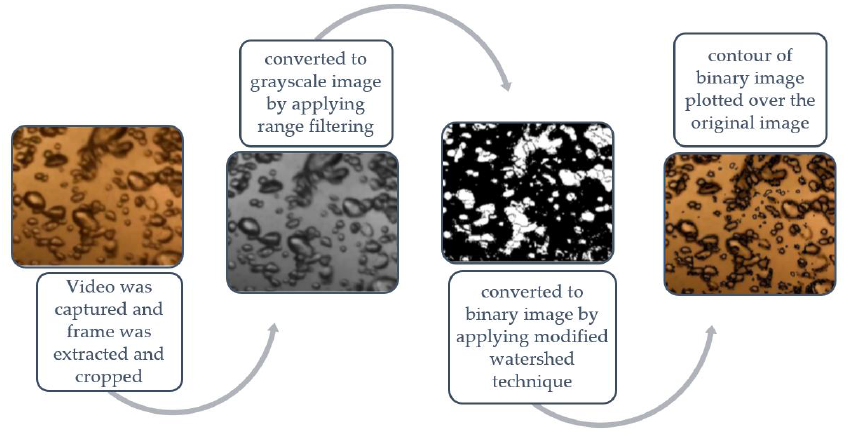
Figure 1. Results of the image processing algorithm.